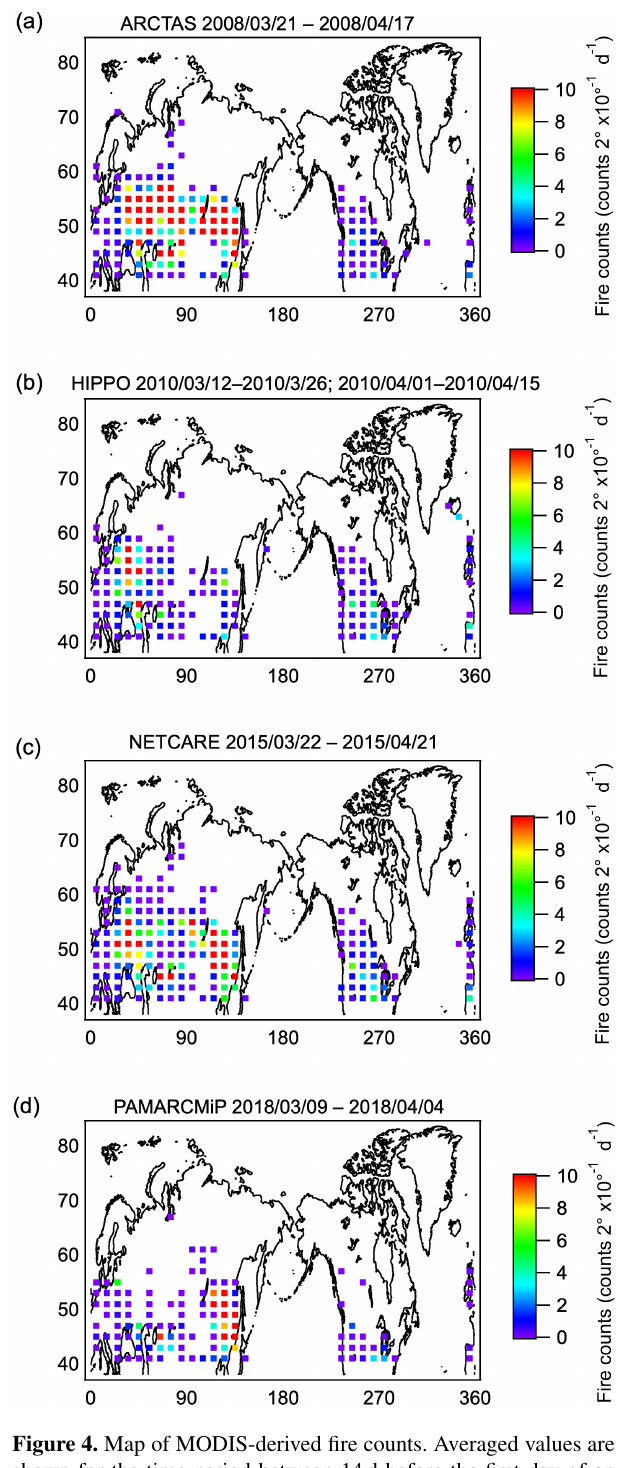
Figure 4. Map of MODIS-derived fire counts. Averaged values are shown for the time period between 14d before the first day of an aircraft-based experiment and the last day of the